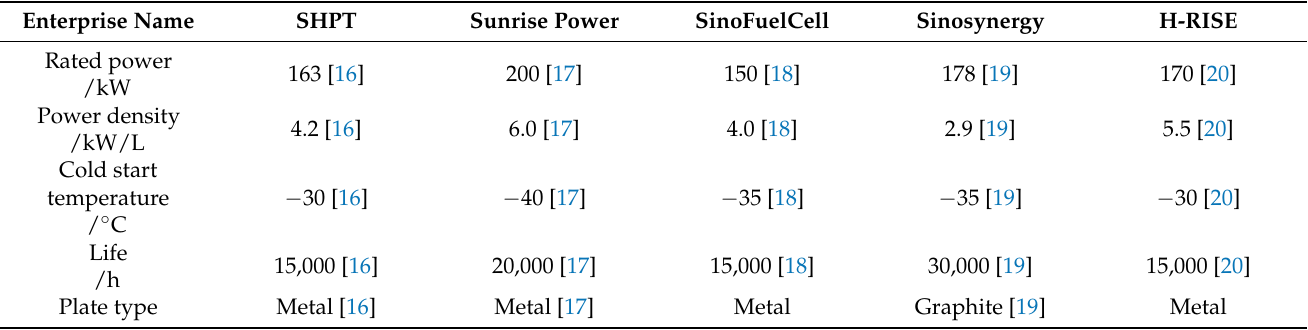
Table 1. Comparison of stack technology levels of some Chinese stack enterprises.